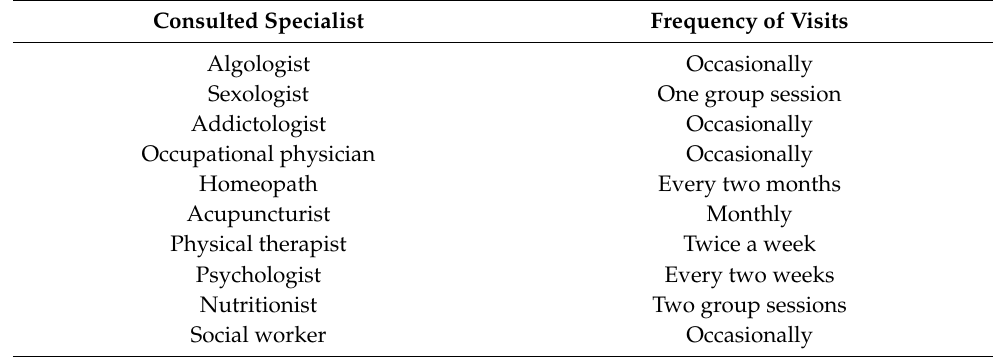
Table 3. General scheme of the conventional supportive care intervention during the six-month follow-up for each